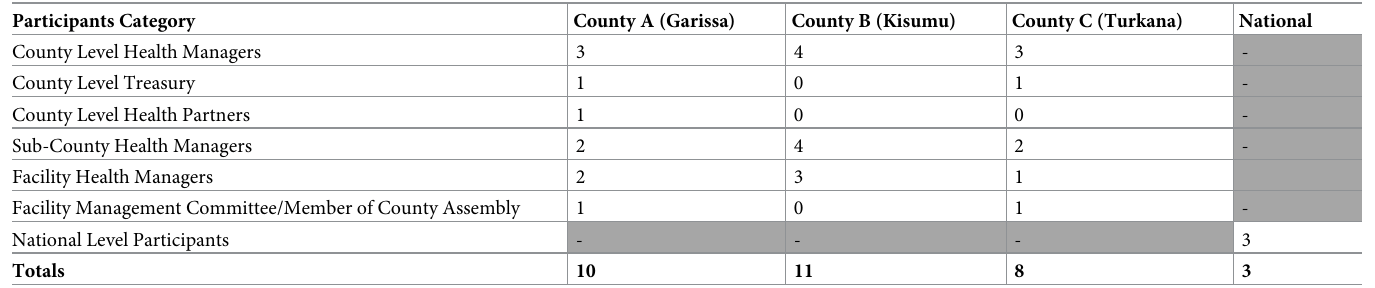
Table 2. Characteristics of interview